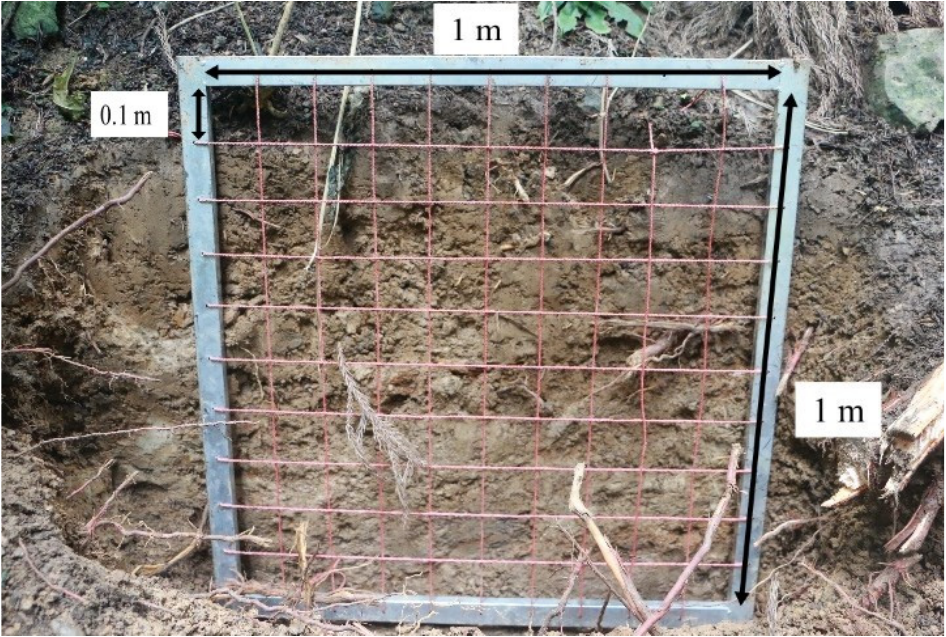
Figure 2. Map showing the one of the soil profile in field condition and the measurement apparatus.